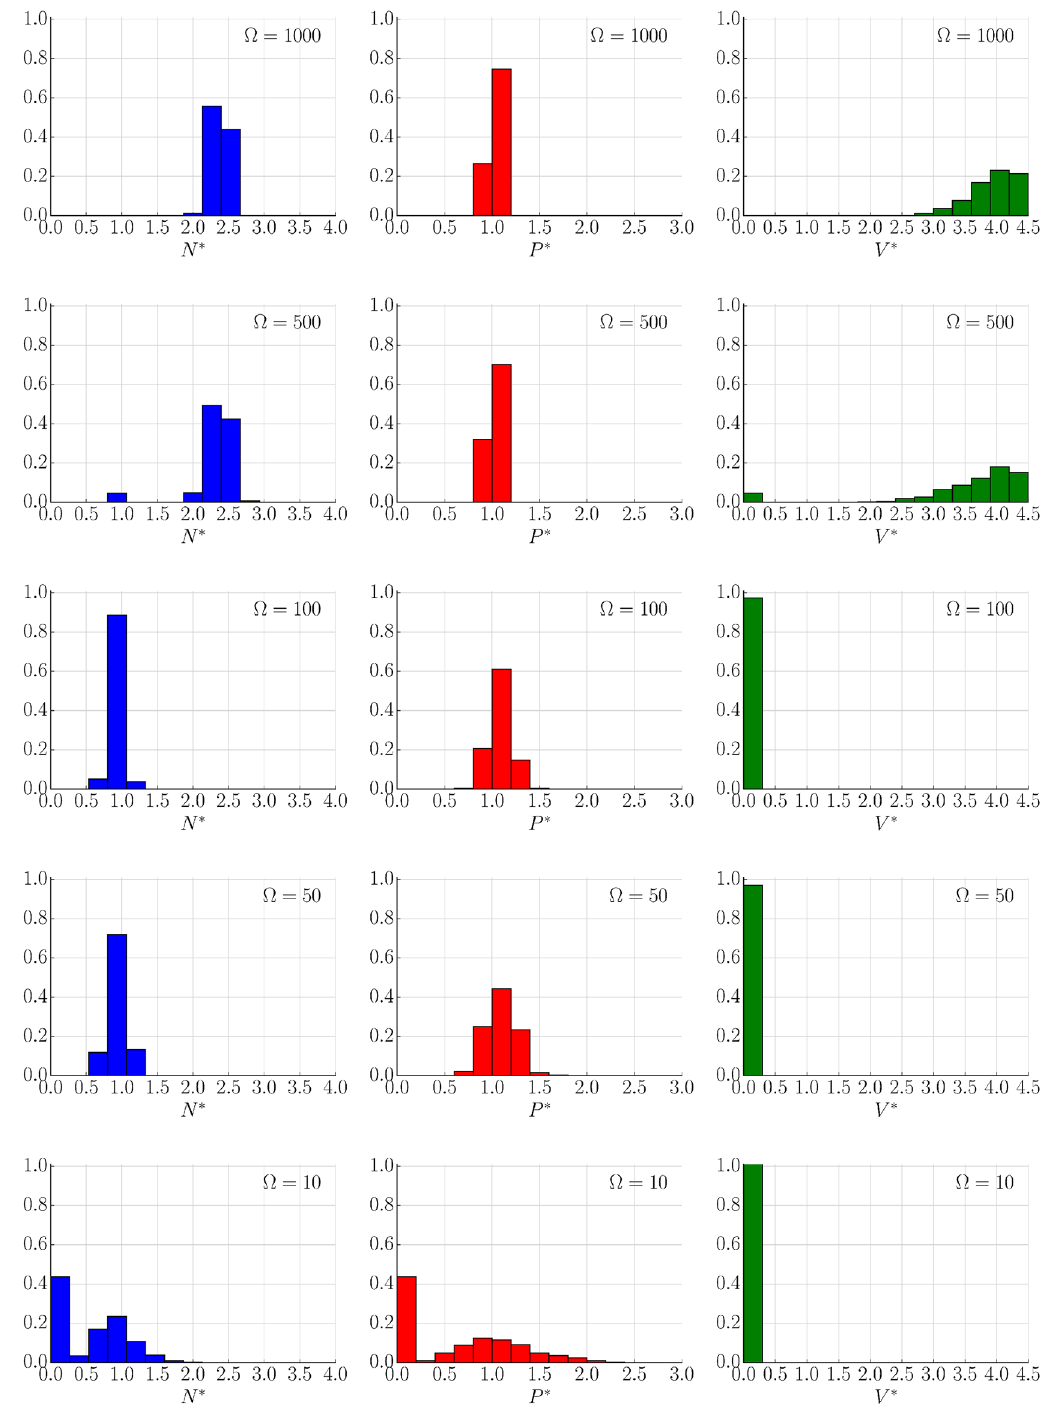
Fig 6. System size determines stochastic populations (Langevin dynamics). Distribution of ( N * , P * , V * ) at time t total = 10000 of 1000 different realizations of Langevin simulation for different values of Initial condition N * = 2.2, P * = 1.0, V * = 3.5 (close to steady stable state C 3 ). The parameters are those of Fig 4.